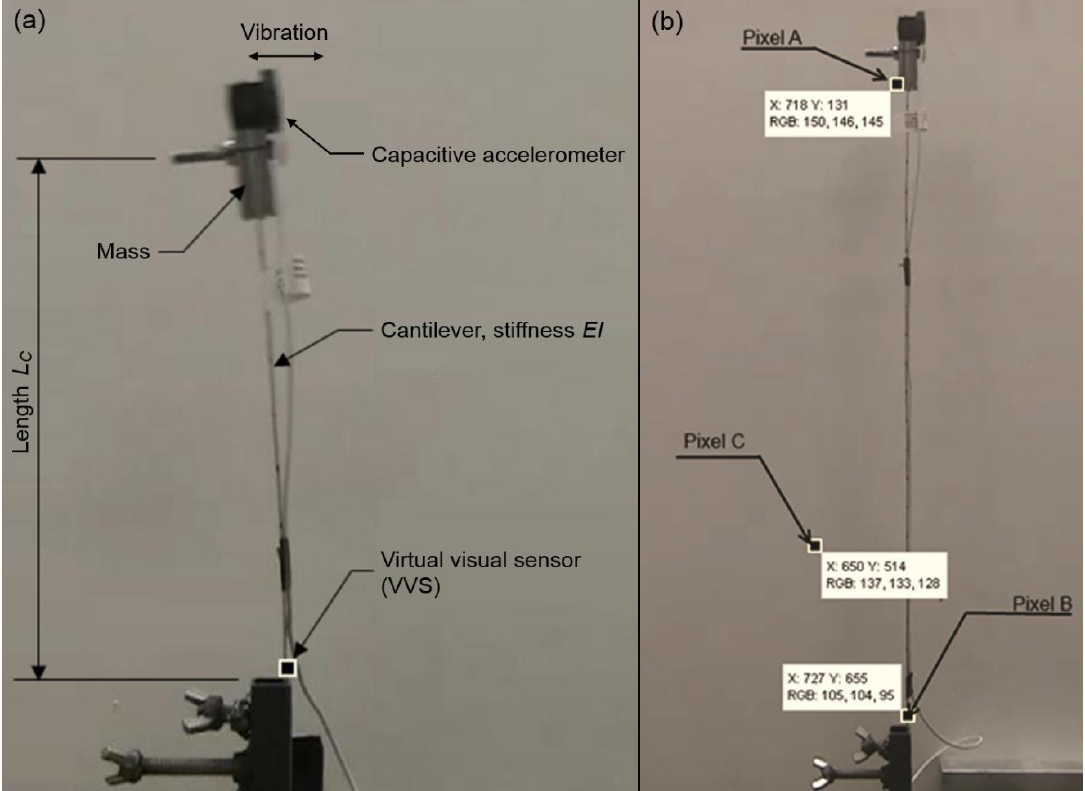
Figure 4. ( a ) Snapshot of moving cantilever and ( b ) candidate virtual visual sensors